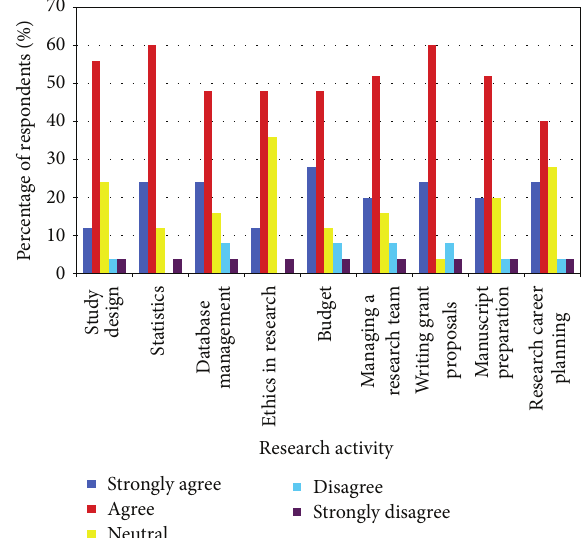
Figure 2: Response of critical care trainees to the survey question: